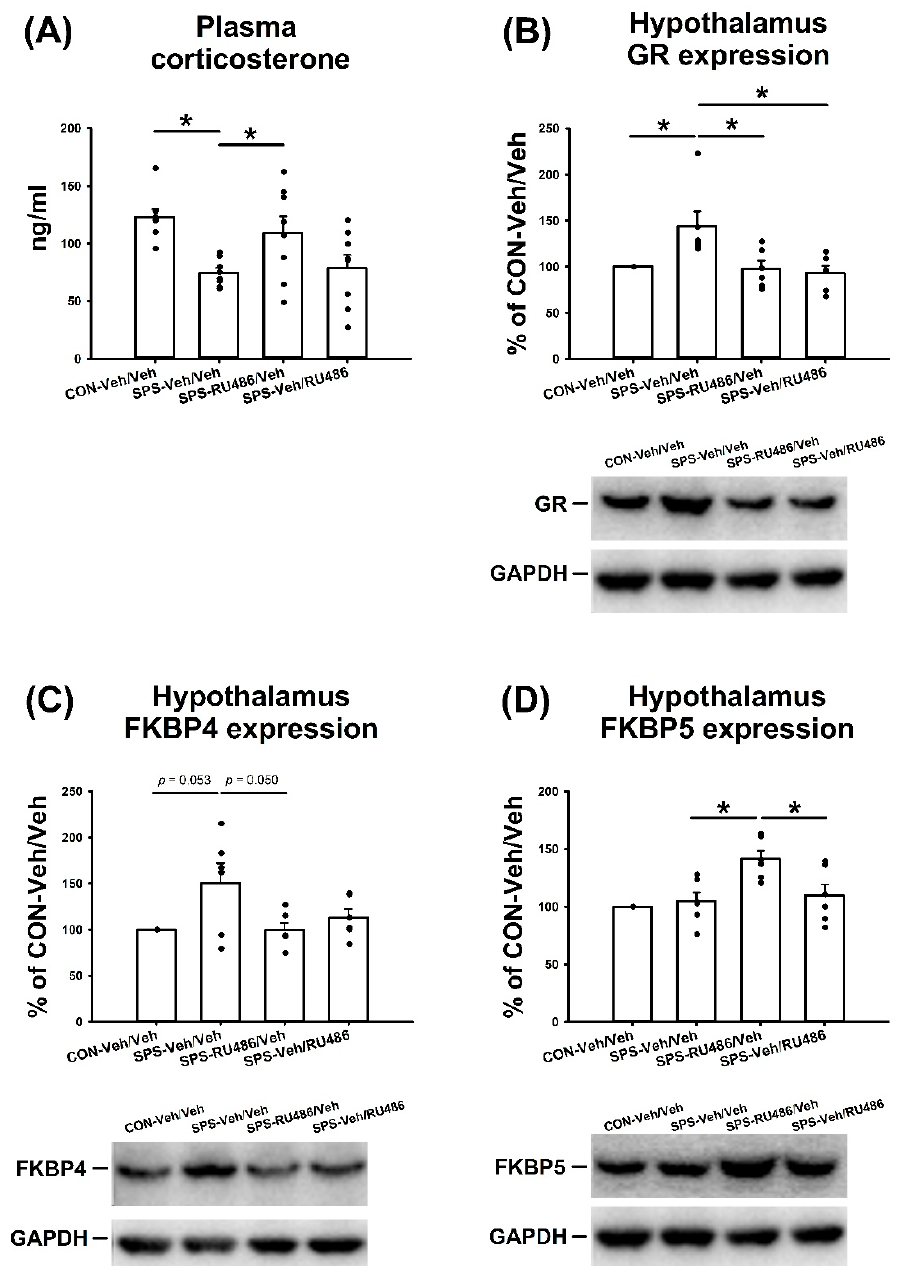
Figure 6. ( A ) The concentration of Plasma corticosterone concentration and the expressions of the ( B ) GR, ( C ) FKBP4, ( D ) FKBP5 in the hippocampus after SPS paradigm and early/late RU486 intervention. The data represent the mean ± SEM. n = 8 in the data of plasma corticosterone level, and n = 6 in the data of western blot for each group. Statistical analysis was employed with a one-way ANOVA followed by Bonferroni post hoc testing. * p < 0.05.